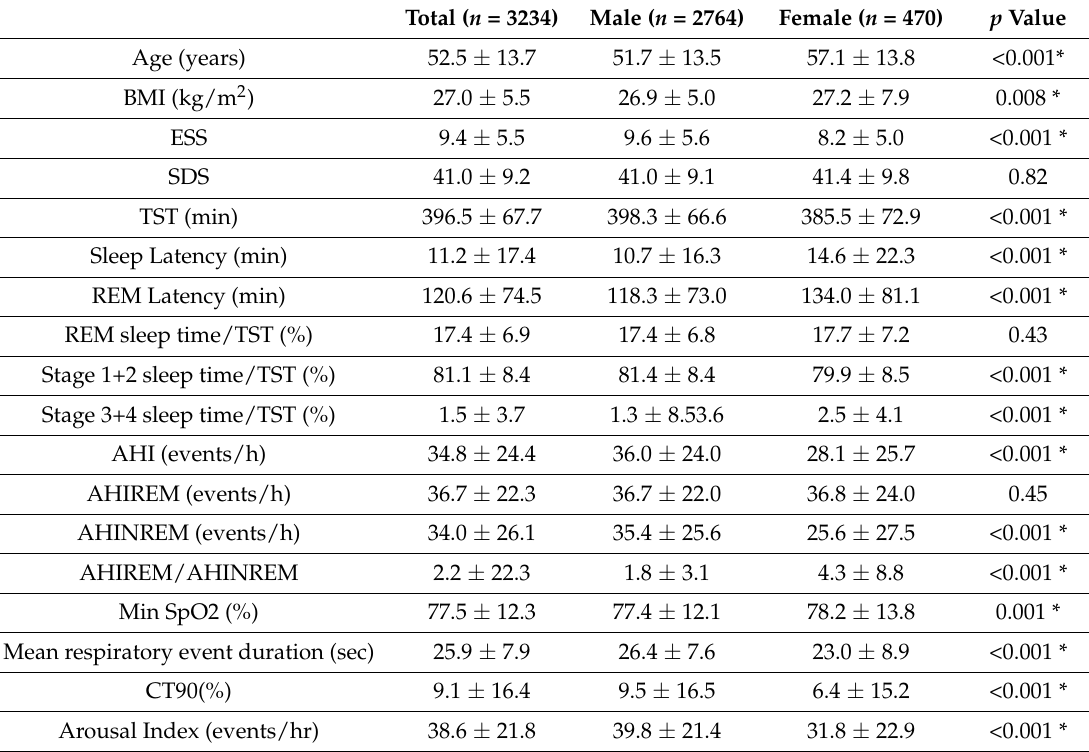
Table 1. Baseline characteristics and polysomnographic parameters of male and female OSA patients.